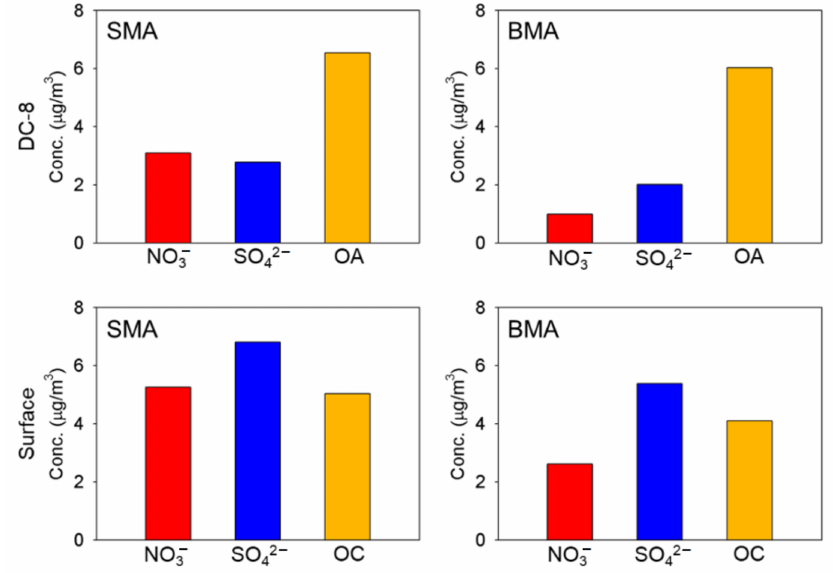
Figure 3. Aircraft-based (KORUS-AQ) upper-layer measurements versus ground-level observations of nitrates, sulfates, and OC in SMA and